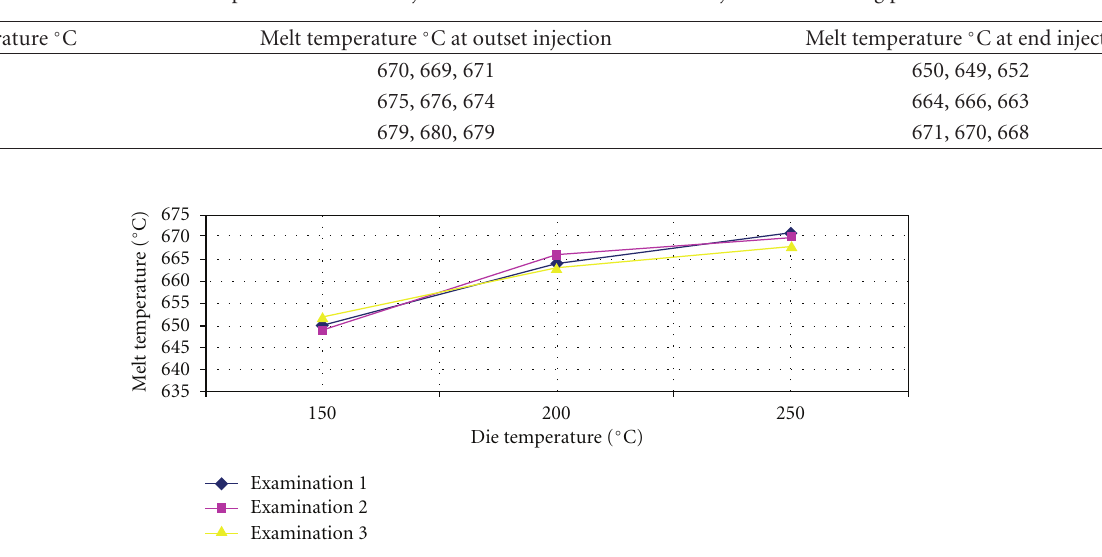
Table 3: Melt temperature at outset injection in shot sleeve and at end injection final filling position.